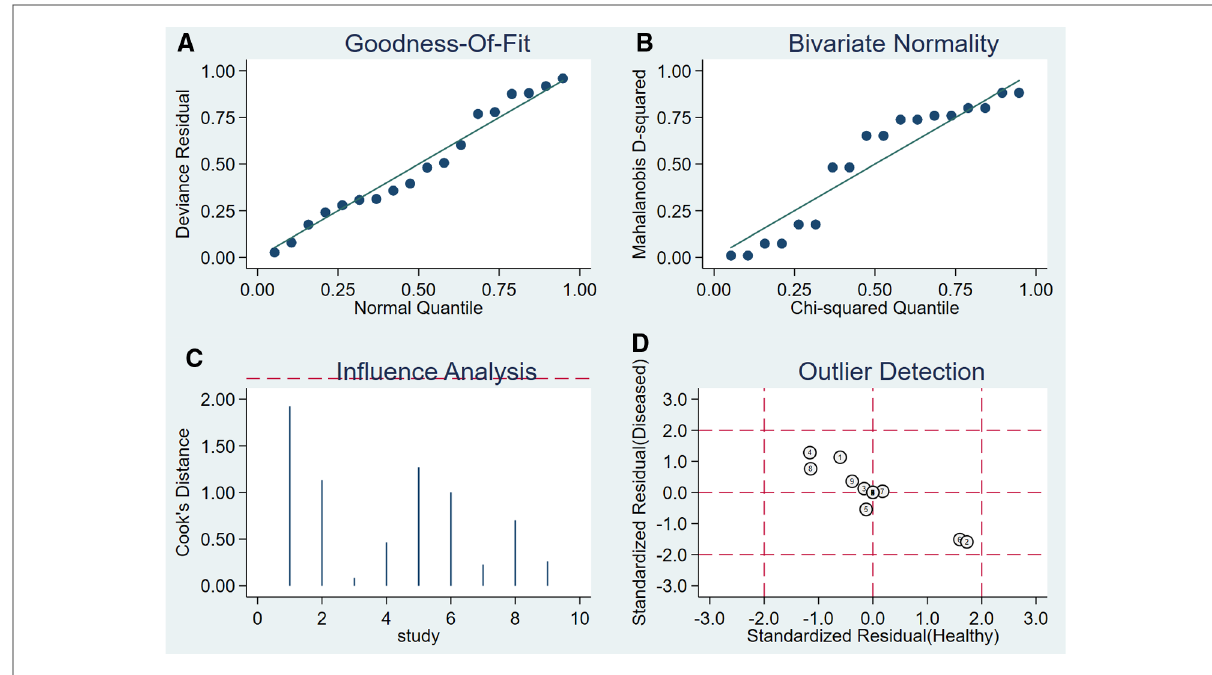
Figure 11 The sensitivity analysis of myelography.